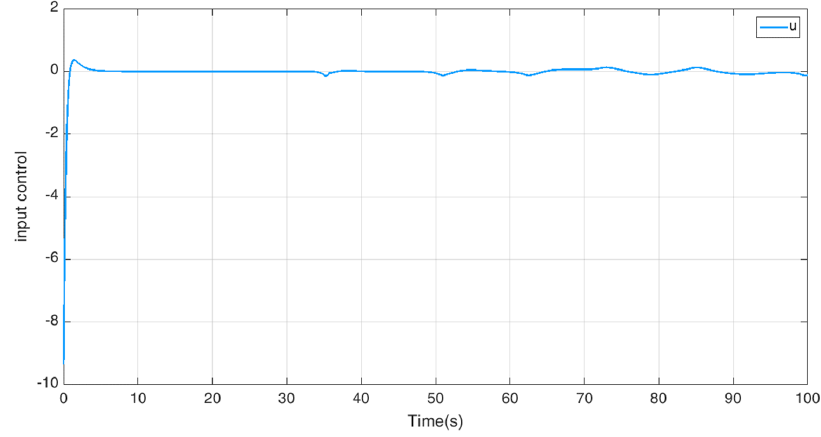
Figure 9. Input control.